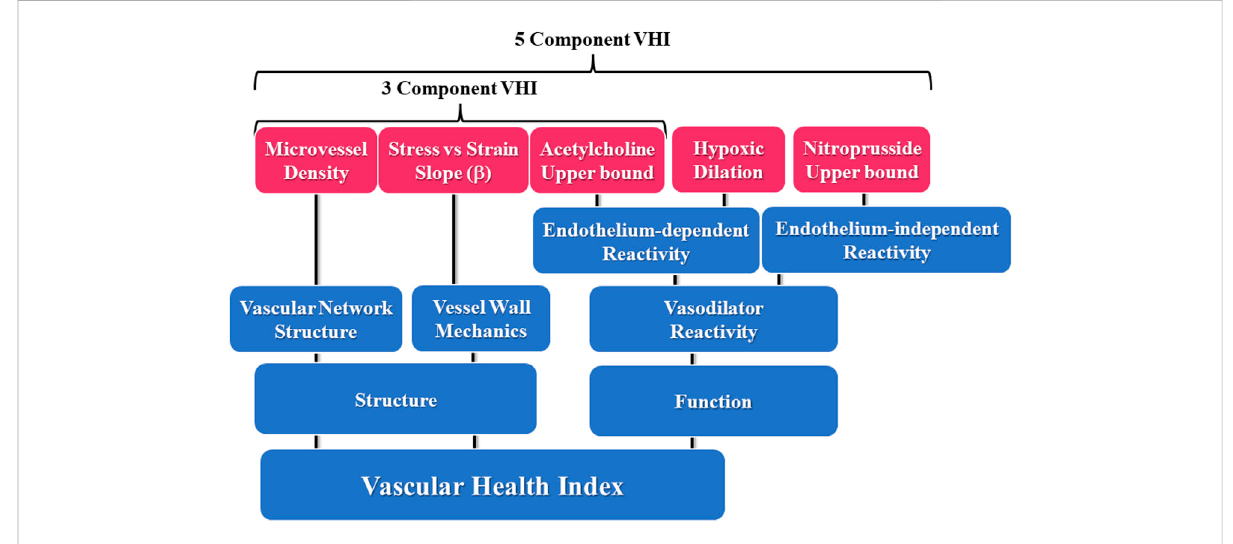
FIGURE 1 Schematicrepresentationofthecomponents contributing tothe5-and3-parameter calculations for theVascularHealthIndex(VHI),andtheir context within the scope of vascular structure and function. Please see text for